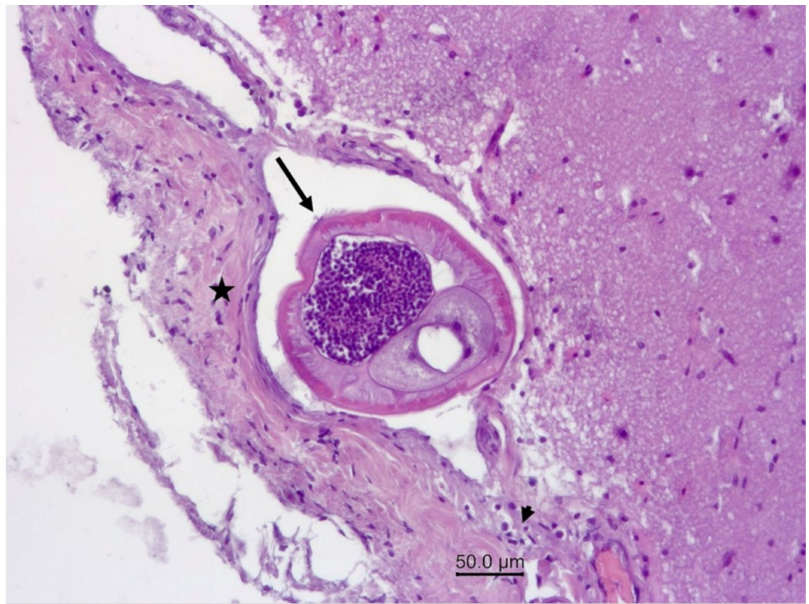
Figure 5. Wapiti, case 1, leptomeninges, histopathology, HE, × 100. Cross-section of a nematode in a vein (arrow). The blood vessel is surrounded by proliferating connective tissue (star) and a small number of inflammatory cells